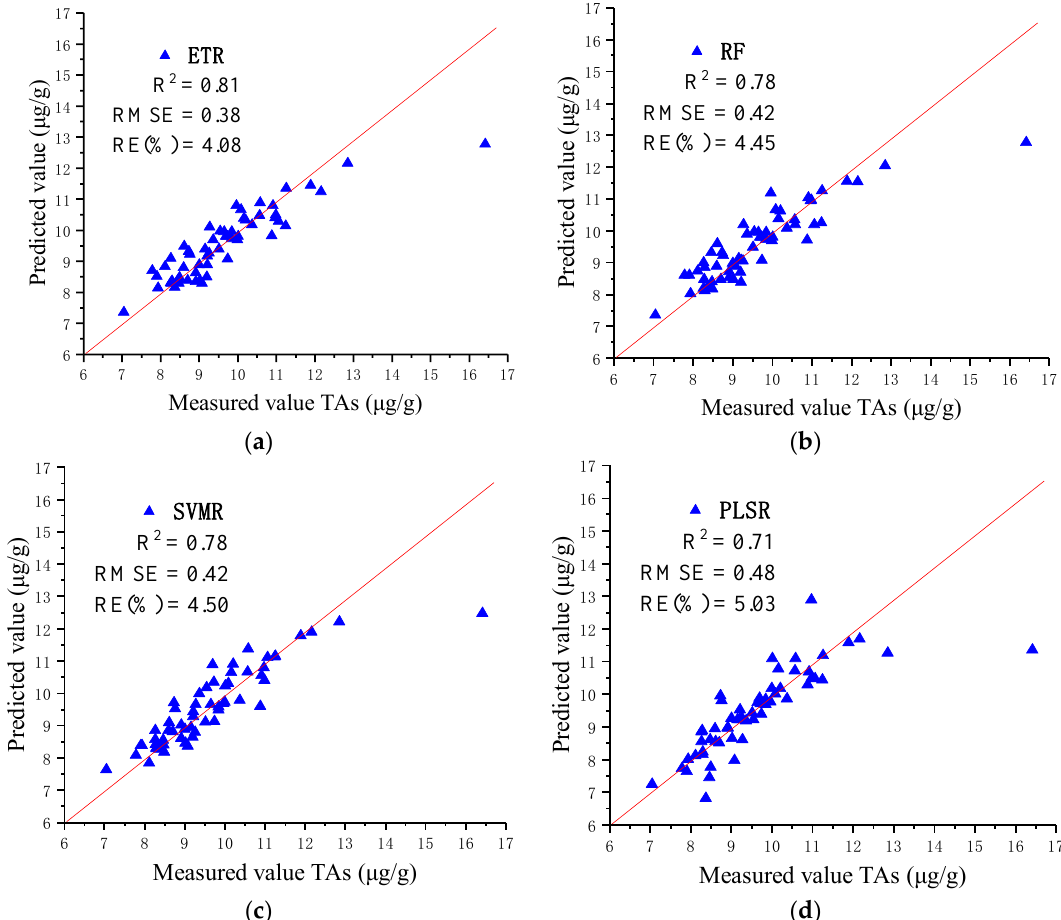
Figure 5. Comparison between the measured values and predicted values of the different regression models. ( a ) ETR; ( b ) RF; ( c ) SVMR; ( d ) PLSR.